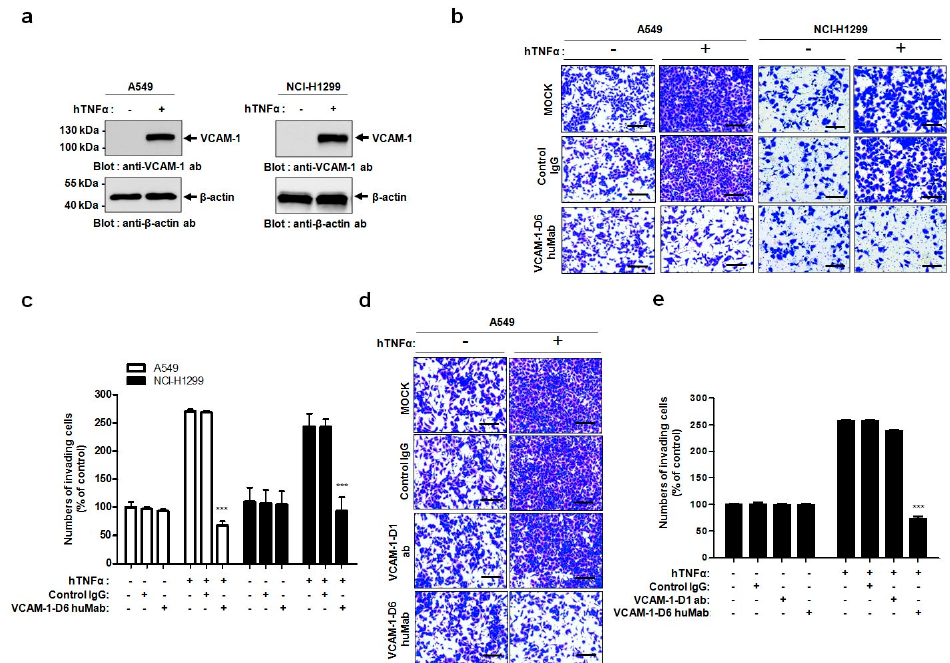
Figure 4. Effects of VCAM-1-D6 huMab on lung cancer cell migration into Matrigel. ( a ) Representative immunoblots show the expression of VCAM-1 in A549 and NCI-H1299 lung cancer cells in the absence or presence of hTNF α ; ( b ) Representative images highlight the effects of VCAM-1-D6 huMab treatment on A549 and NCI-H1299 cell migration into Matrigel, in the absence or presence of hTNF α , compared with those of control IgG treatment (200× magnification, scale bar = 200 µm); ( c ) The numbers of A549 and NCI-H1299 migrating cells into Matrigel in the presence of control IgG or VCAM-1-D6 huMab are expressed as a percentage of the mock control values. The values represent the mean ± SEM of triplicate measurements from one of three independent experiments (*** p < 0.001); ( d ) Representative images highlight the specific effects of VCAM-1-D6 huMab on A549 cell migration into Matrigel, in the absence or presence of hTNF α , compared with those of a VCAM-1-D1 blocking antibody or control IgG (200× magnification, scale bar = 200 µm); ( e ) The numbers of migrating cells into Matrigel in the presence of control IgG, VCAM-1-D1 blocking antibody, and VCAM-1-D6 huMab are expressed as a percentage of the mock control values. The values represent the mean ± SEM of triplicate measurements from one of two independent experiments (*** p < 0.001).